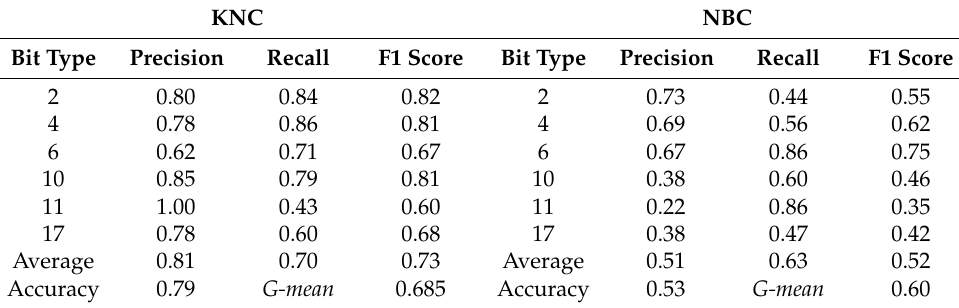
Table 11. The screening of 12.25” bit through KNC and NBC models. KNC Bit